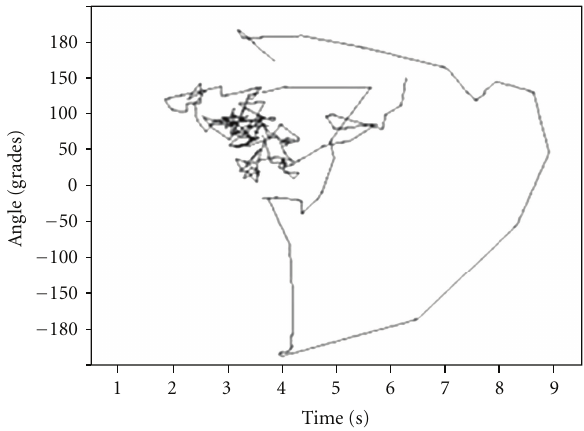
Figure 7: Analysis of parasite trajectory . The trajectory of free- swimming epimastigotes was determined using the speed and rotational angle results form a 10-second recording. The histogram is representative of the average behavior of 20 randomly selected